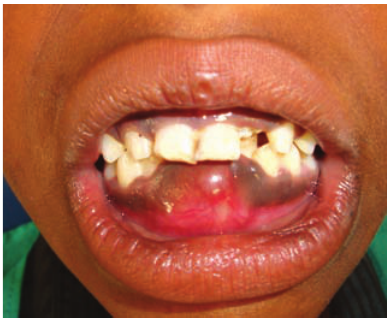
Figure 2. Photograph showing ovoid, firm, intra oral swelling, measuring about 2 ¥ 2 cm in relation to mandibular incisor area causing lateral displacement of both central